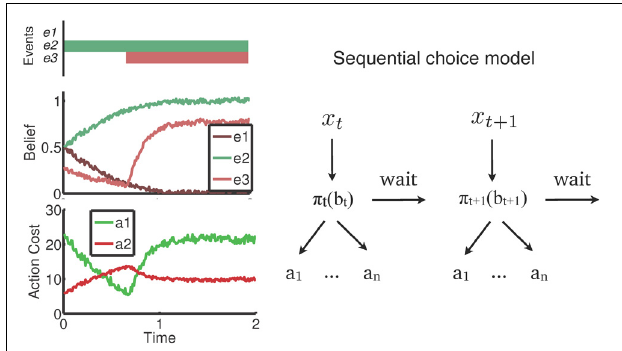
FIGURE 1 | Rational decision-making in inhibitory control. The figure abstracts out ideas common across recent decision-making models for inhibitory control into a single framework. Left : an example where task-relevant events e1 and e2 are mutually exclusive (e.g., a forced choice stimulus), and e3 occurs at some later point in time. Sensory evidence from these events are gradually reconciled with prior expectations to form a noisy, evolving belief, or subjective probability, about whether the event occurred. These beliefs form the basis of an ongoing valuation of, and selection between, available actions. Right : A representation of this sequential decision-making process. At each time point, noisy sensory inputs ( x i ) are incorporated into beliefs ( b i ), which are transformed into a choice between actions (cid:2) (a1,...an, wait) based on the decision policy (